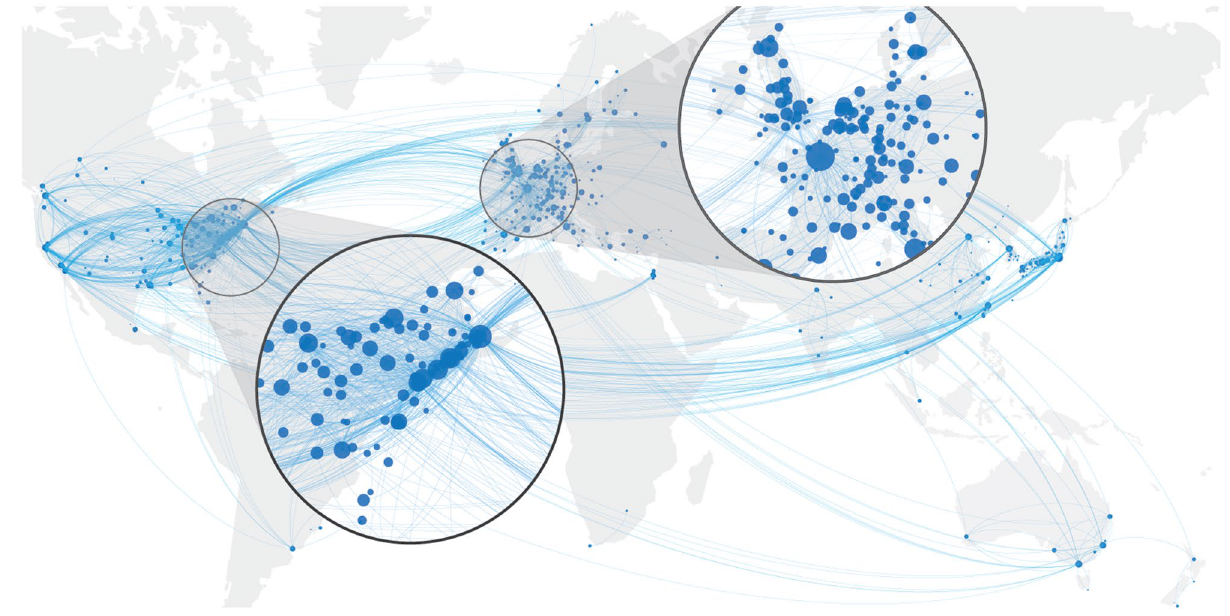
Figure 2. The intercity mobility network at global scale. Only locations with at least 50 active scientists in the period 2000 to 2006 are shown. The link width indicates the logarithm of the flows between the given cities. The node size is proportional to the number of scientists stationary in that